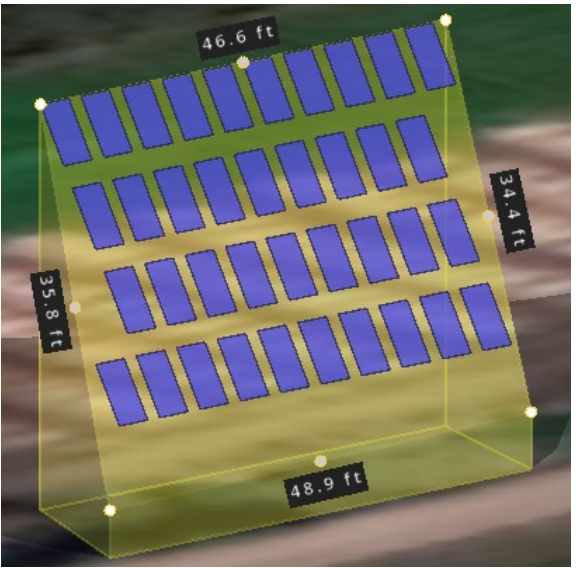
Figure 12. Helioscope top illustration accommodation investigation.